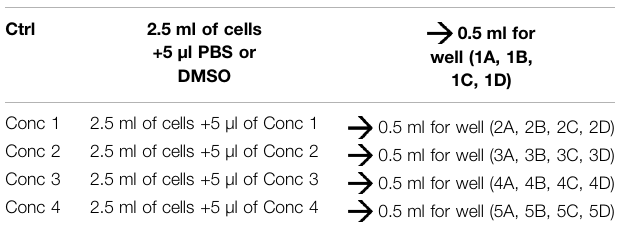
TABLE 6 | Treatment